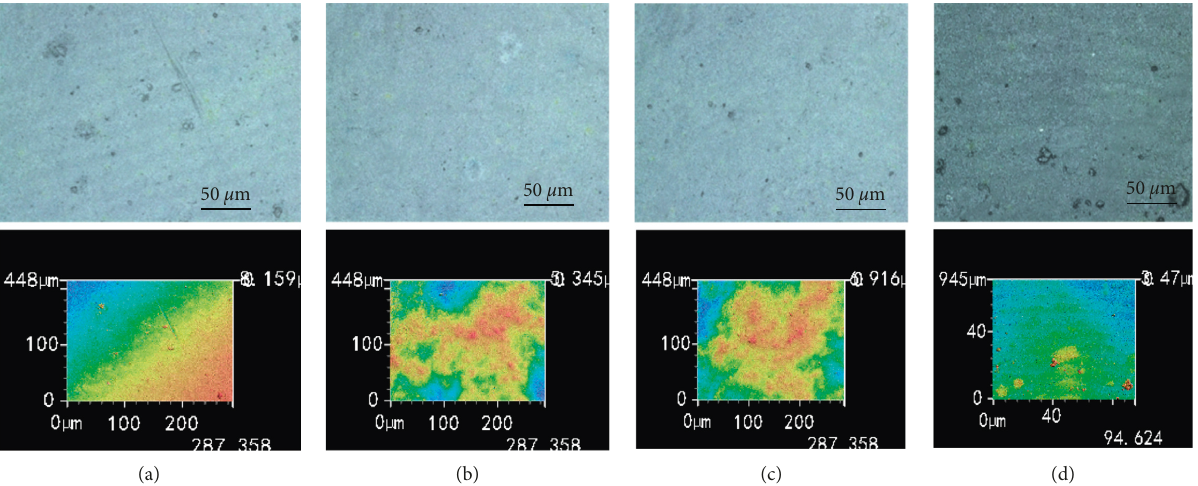
Figure 9: LSCM micrographs of the AQ80M alloy with multiple coatings under different strains: (a) 0.3 σ 480h, and (d) 0.75 σ 0.2 (c) 0.6 σ 0.2 × ×